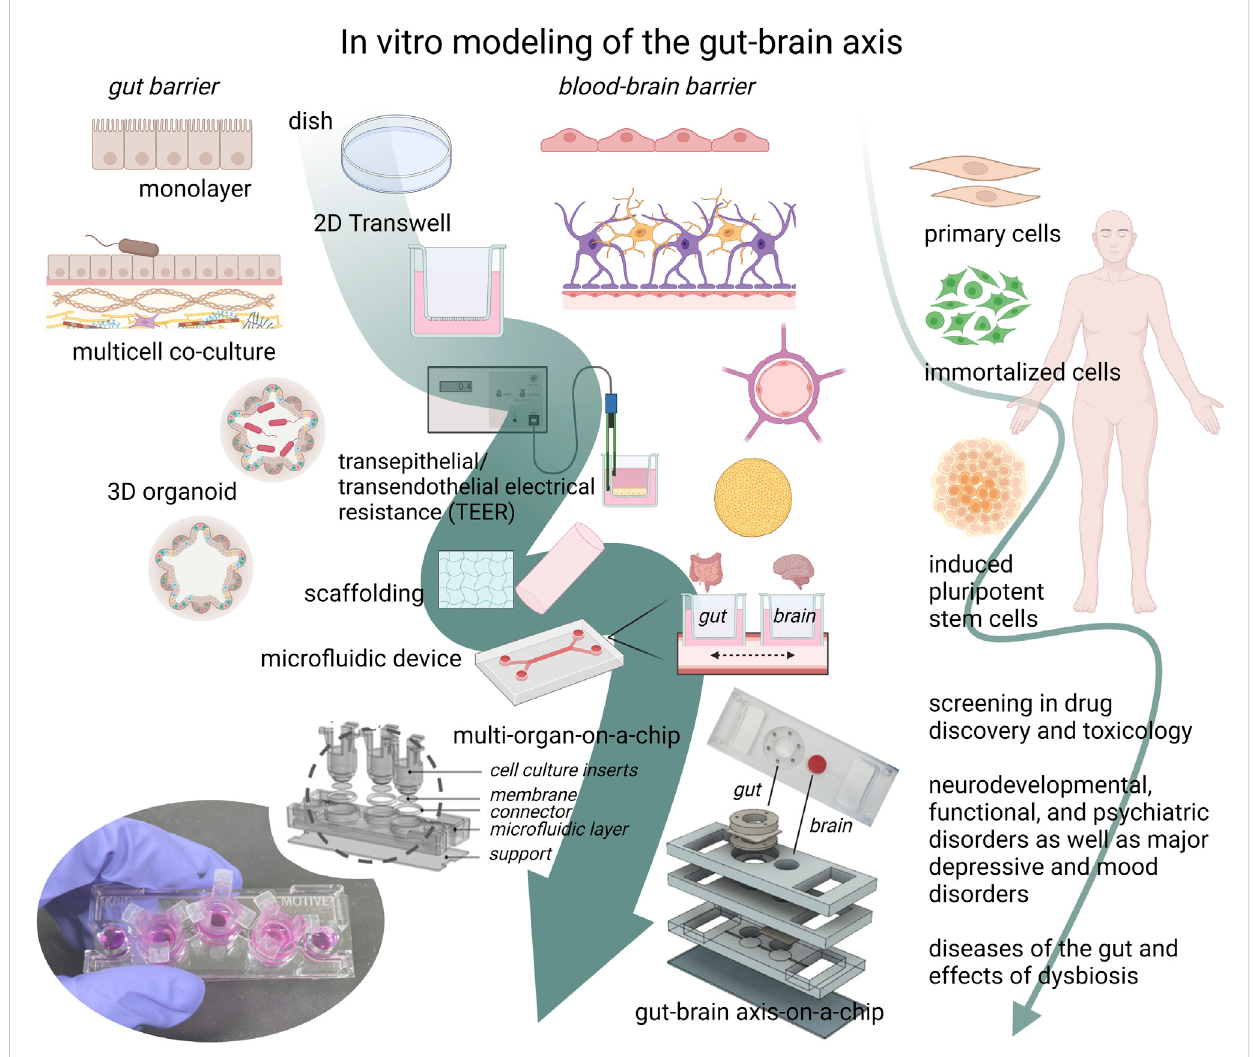
FIGURE 2 The development towards complex gut-brain axis models. The gut microbiome (GM), the gut barrier, and the blood-brain barrier (BBB) are key elements ofthegut-brainaxis (GBA). Individually, theyhave been extensively modeled withdifferent invitro approaches, rangingfrom mono- and multi- cellular co-cultures with or without gut microbe exposure, to 3D organoids or tissue models. Cell models can be derived from animal or human primary cells,developedfromimmortalizedcelllines,orfromstemcells,ofwhichtheinducedpluripotentstemcell(iPSC)technologyhasadvancedthecell model fi eld forward. With this method, patient- or disease speci fi c cells can be studied in an in vitro setting, providing a platform for drug screening in relevant complex human cell models. The advances in organ-on-a-chip technology and induced pluripotent stem cell (iPSCs) methods may together contribute further to the physiological complexity of gut-brain-axis-on-a-chip models, with which new mechanistic hypotheses and functions can be studied. The ability to mimic the complex physiological functions of the GBA in vitro is needed in basic research as well as in disease research of psychiatric,neurodevelopmental,functional,andneurodegenerativediseases,suchasAlzheimer ’ sdisease.(The fi gurewascreatedwithBiorender.GBA- and organ-on-a-chip fi gure and image were kindly supplied by Professor Jong Hwan Sung, Dep. Of Chemical Engineering, Hongik University, Seoul,